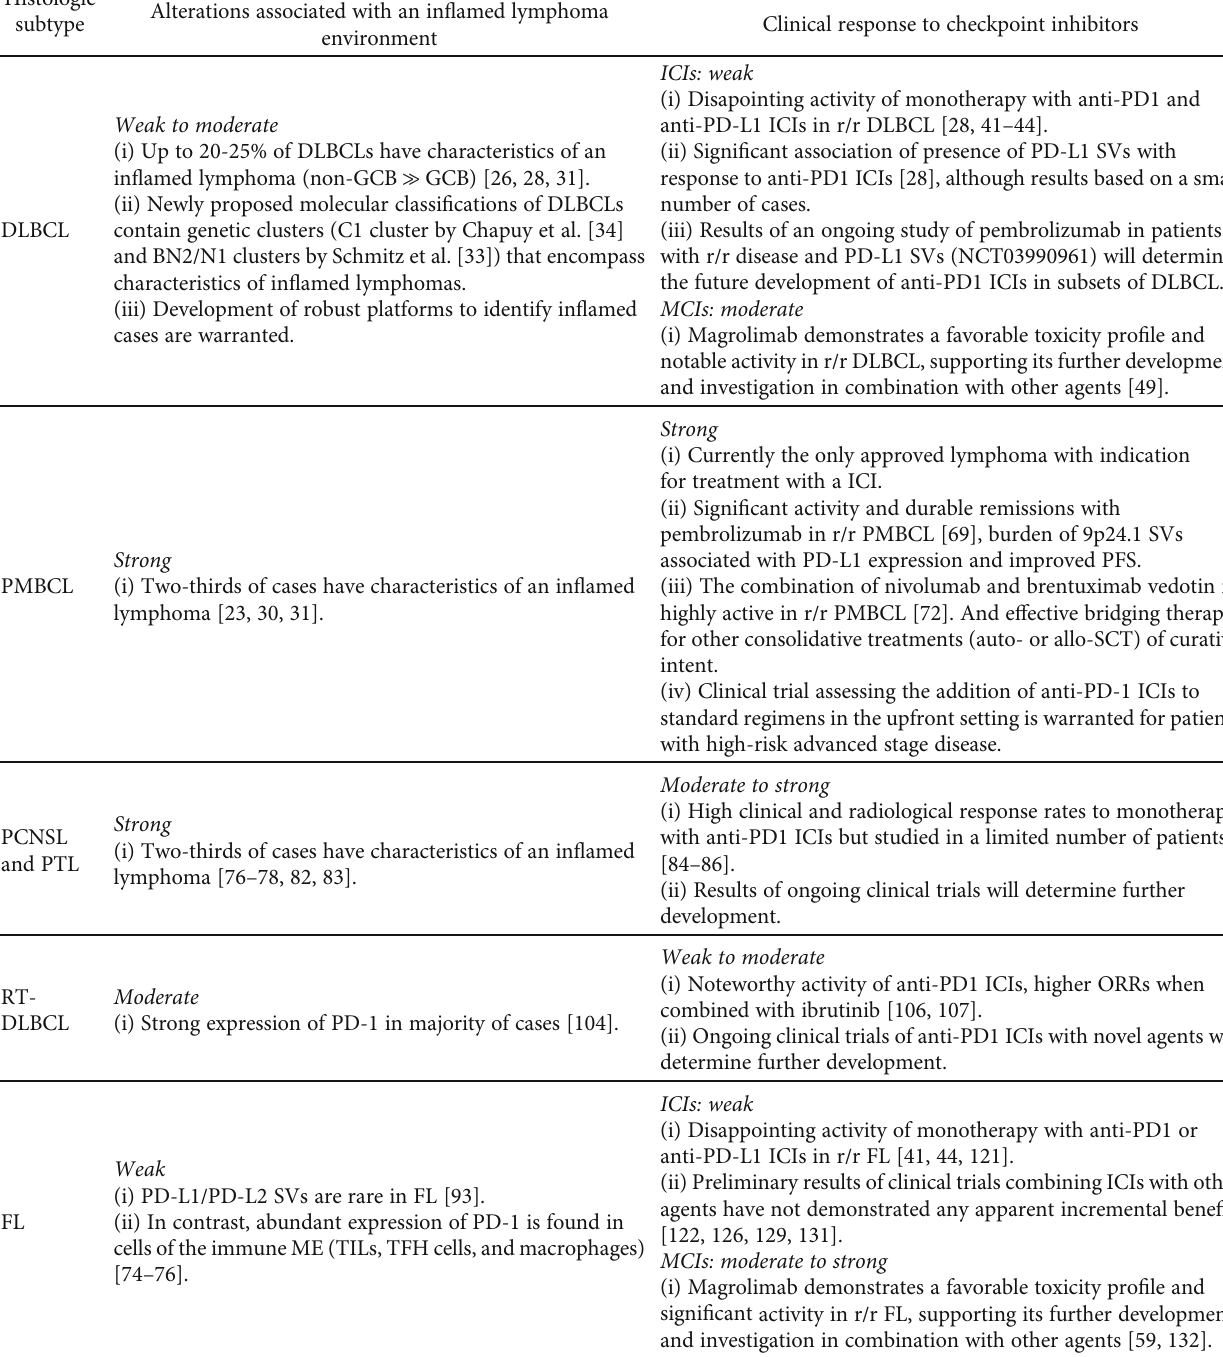
Table 1: Synopsis of current evidence and evolving role of checkpoint inhibitors in selected subtypes of B-cell NHL.